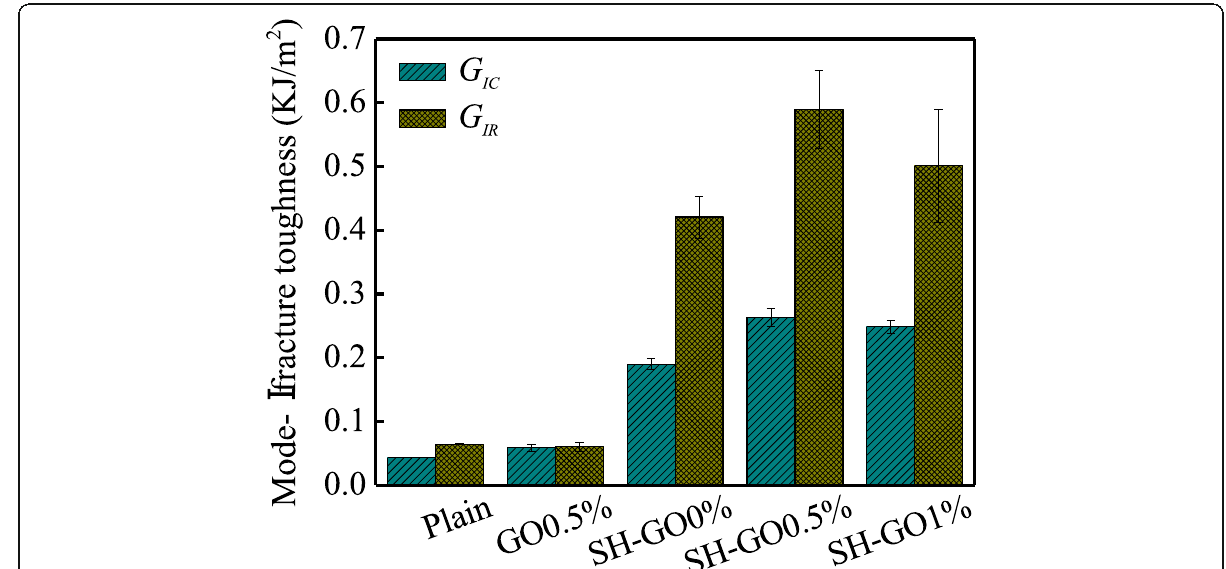
Fig. 11 Comparison of the mode-I fracture toughness and resistance for various